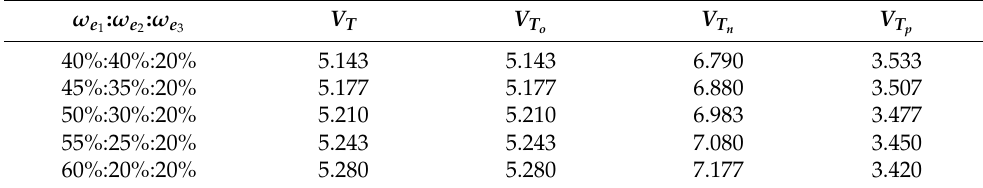
Table 6. Sensitivity analysis of weight for project value. Currency: US$ Unit: million dollars.